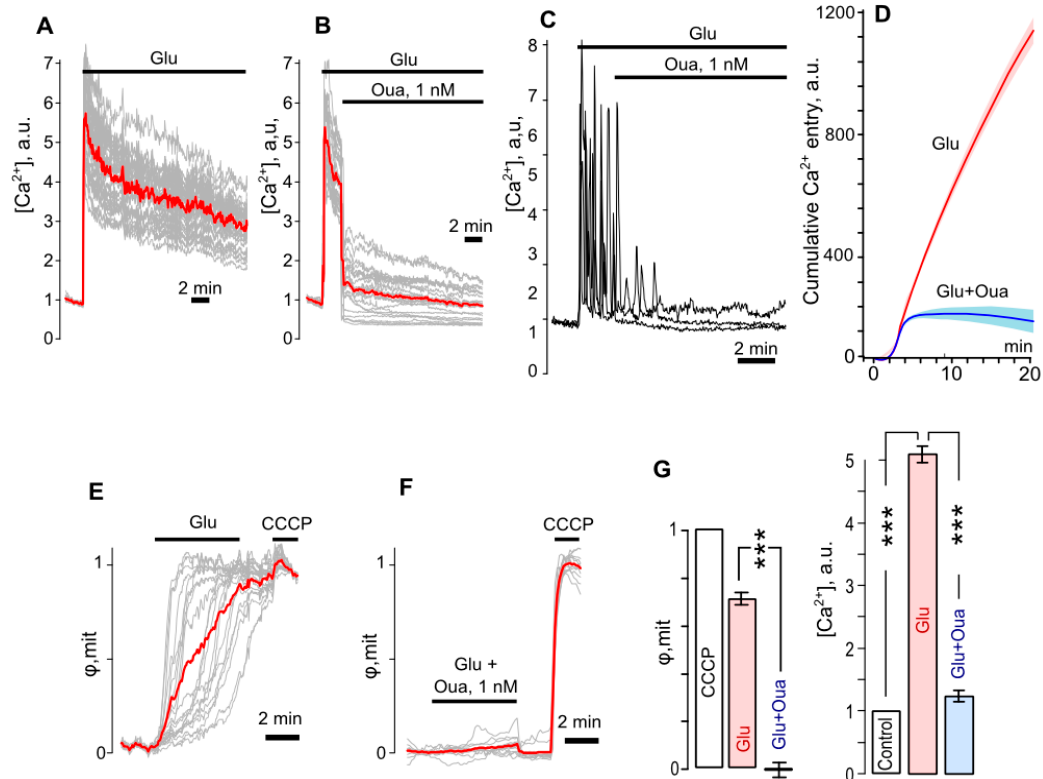
Figure 3. Ouabain prevents the intracellular Ca 2 + overload and the loss of mitochondrial inner membrane potential of cortical neurons caused by glutamate. ( A ) Fluorescent Ca 2 + responses of neurons loaded with Fluo-8 evoked by an application of 100 µ M glutamate + 30 µ M glycine (Glu) obtained from the same experiment and normalized to the fluorescence intensity recorded without Glu. Gray lines—responses of single neurons. Red line—an average response. ( B ) Ca 2 + responses when 1 nM Oua was added on the top of Glu responses. ( C ) Example of Glu responses revealing generation of Ca 2 + transients by neurons. ( D ) Average cumulative curves for Ca 2 + overload evoked Glu (red line) and with an addition of Oua (blue line), which represent an integral of fluorescent Ca 2 + responses shown in panels ( A , B ). Mean value ± SEM for each point is plotted ( n = 7). ( E ) Fluorescent responses of neurons loaded with rhodamine-123 evoked by an application of 100 µ M glutamate + 30 µ M glycine (Glu) that reflect the loss of mitochondrial inner membrane voltage ( ϕ mit ) obtained from the same experiment and normalized to the fluorescence intensity recorded in the presence of 4 µ M CCCP. Gray lines—responses of single neurons. Red line—an average response. ( F ) Changes of ϕ mit when 1 nM Oua was added to Glu. ( G ) Histograms compare average values of ϕ mit obtained with Glu and combined application of Glu and Oua in relation to full loss of ϕ mit in the presence of CCCP (on the left, n = 7) and Ca 2 + response amplitudes obtained under control and with Glu and combined application of Glu and Oua (on the right, n = 7). ***—Data are significantly di ff erent ( p = 0.0006, ANOVA with Tukey’s post- hoc